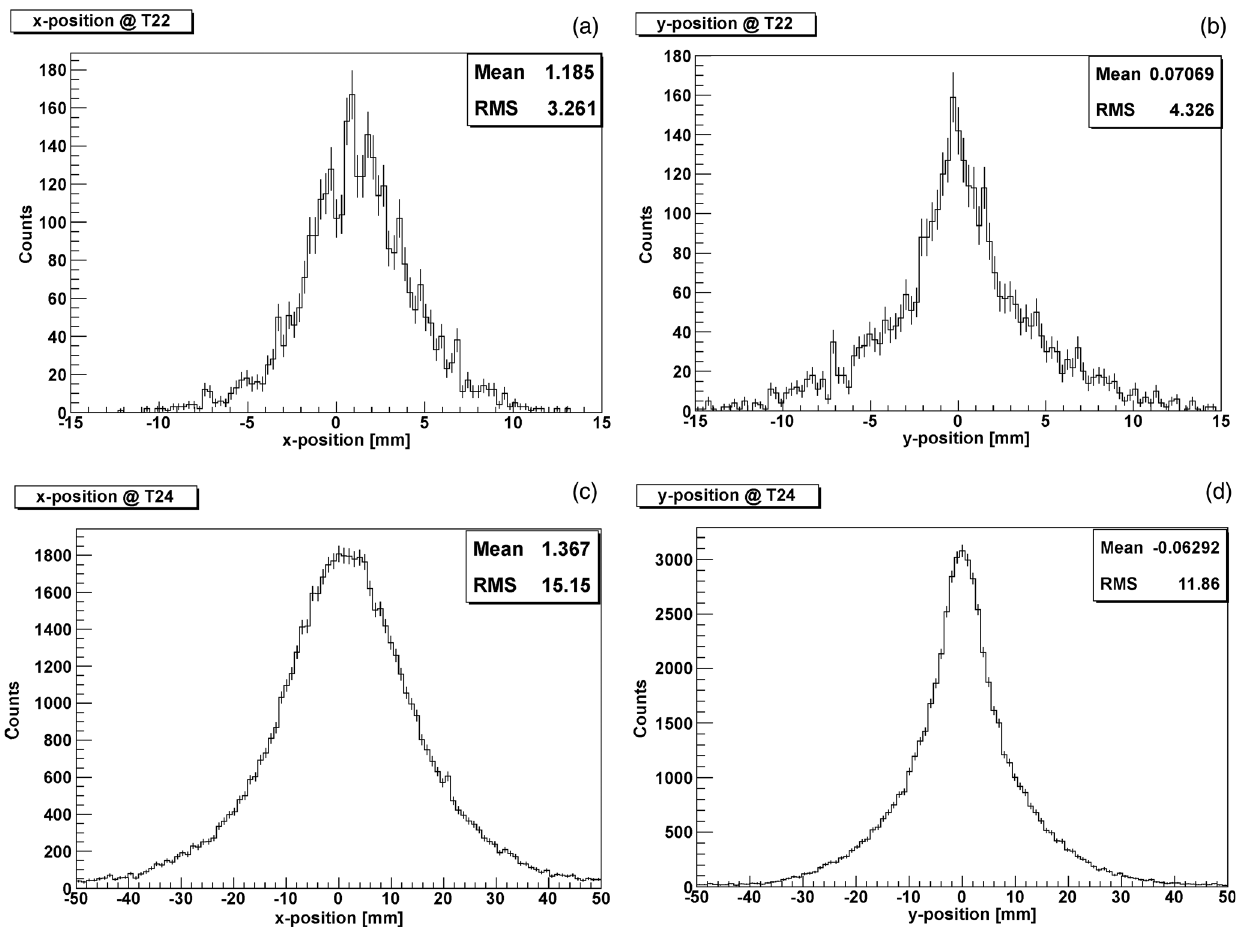
FIG. 9. (a) and (b) The H2 secondary beam profiles at the secondary target, in the horizontal (left) and the vertical (right) planes. (c) and (d) The H4 secondary beam profiles at the secondary target, in the horizontal (left) and the vertical (right) planes.